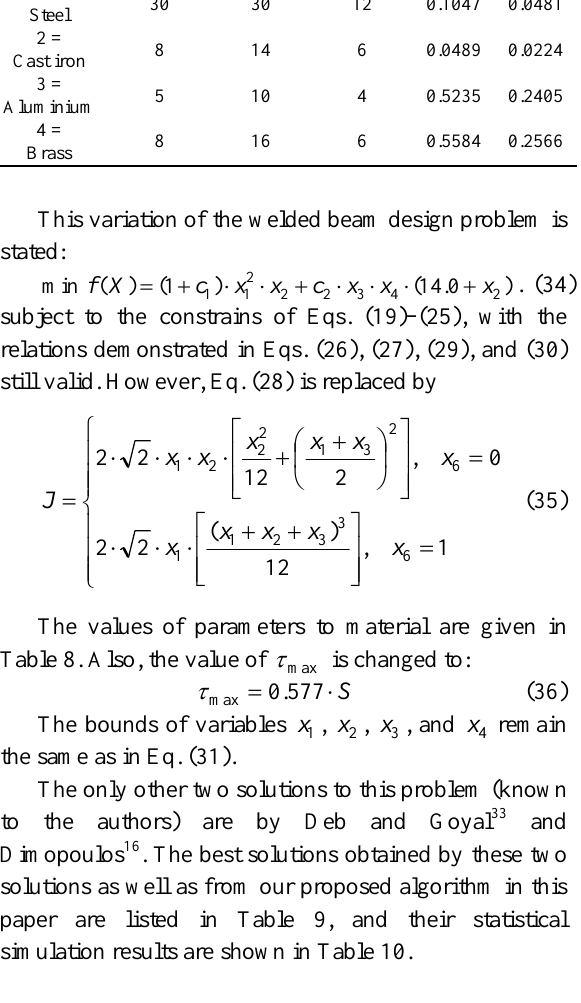
Table 9. Comparison of the best solution for the 2nd variation of welded beam design